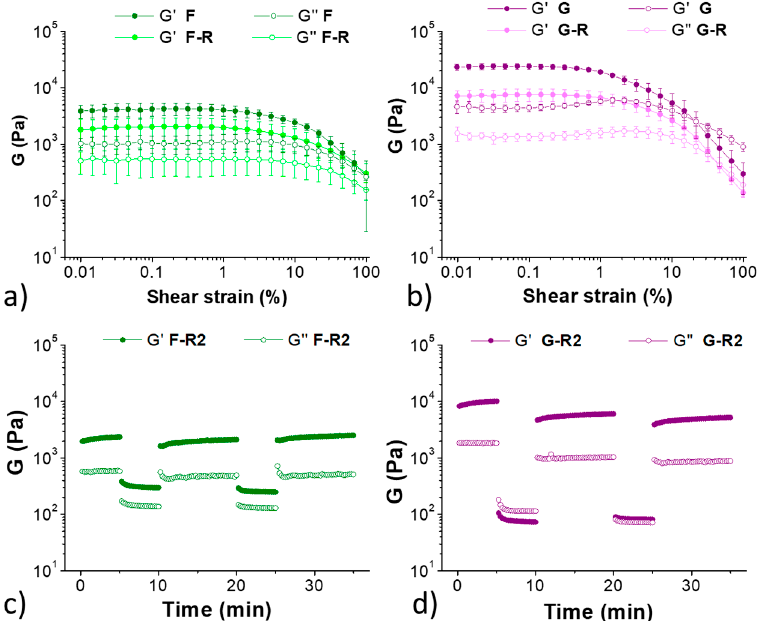
Figure 6. Top: amplitude sweep experiments of the hydrogel F ( a ) before (dark green) and after (light green) a break/recovery cycle. Amplitude sweep experiments of the hydrogel G ( b ) before (purple) and after (pink) a break/recovery cycle. The analyses were repeated in triplicate. Bottom: step–strain experiments of hydrogels F-R2 ( c ) and G-R2 ( d ).